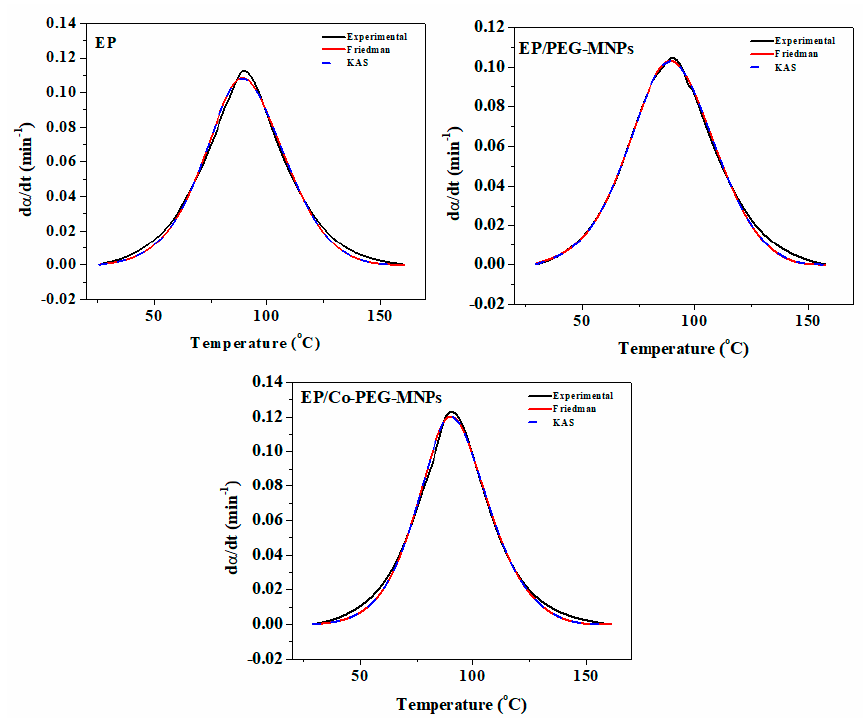
Figure 12. The experimental and the calculated variation of the conversion of the prepared samples (rate of cure reaction) as a function of time.